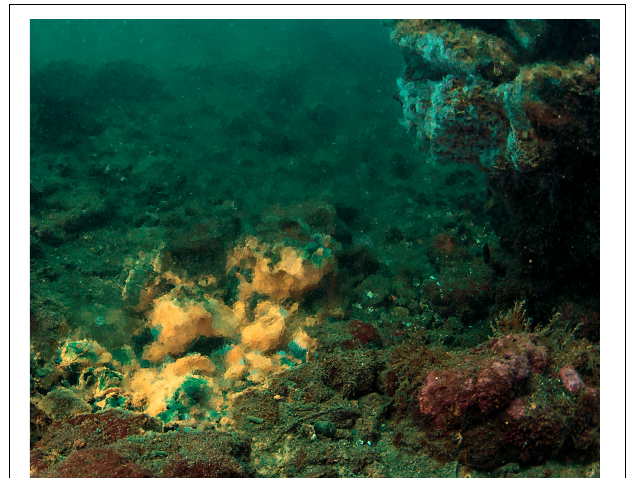
FIGURE 2 | The hydrothermal geyser with surrounding rocky substrate covered by yellow sulfur deposits.